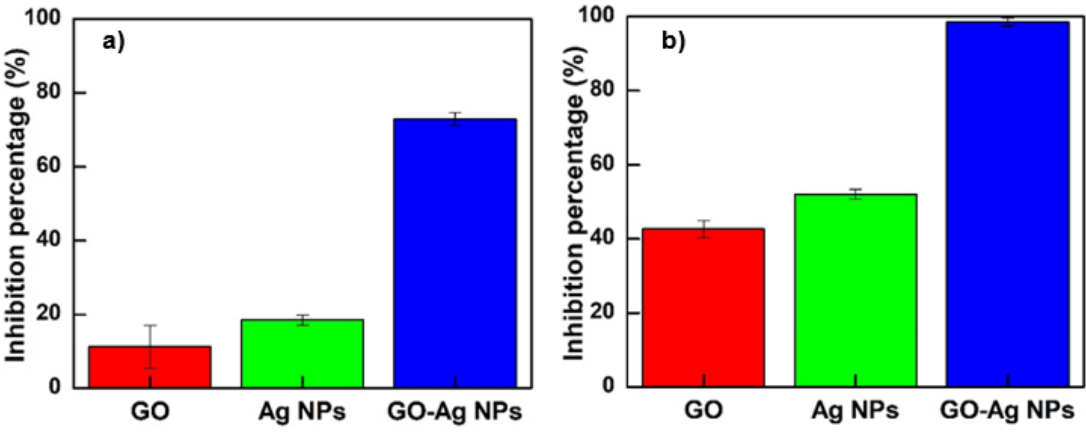
Figure 6. Bacterial inhibition percentage (%) of GO, Ag NPs, and GO–Ag NPs towards E. coli ( a ) and S. Aureus ( b ) for 5 h incubation at the same concentration of 100 µg mL −1 . The results are expressed as the means ± standard deviation of three independent experiments.